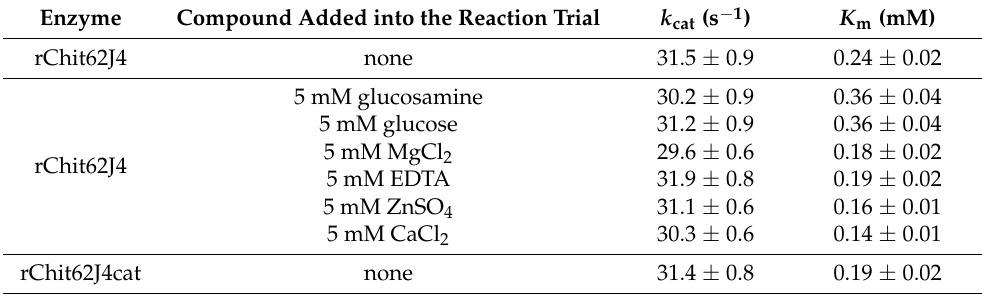
Table 1. Kinetic parameters of rChit62J4 influenced by selected compounds. Standard deviations are